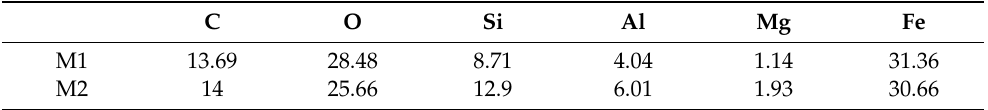
Table 5. Chemical composition of the third bodies in load-bearing plateaus of the M1 and M2 friction tests (wt. %).